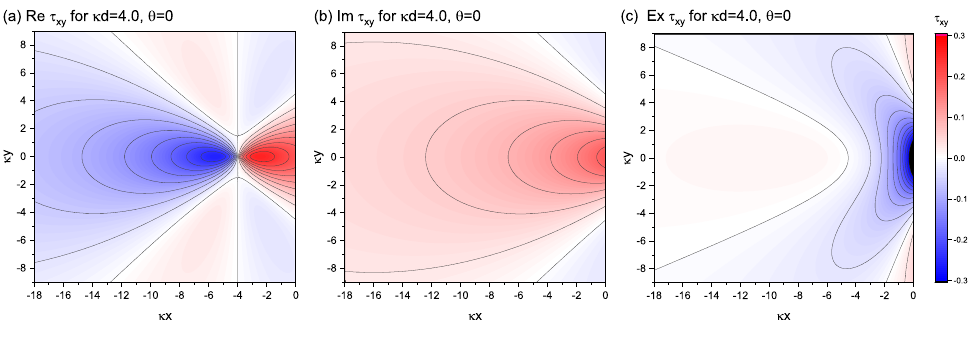
( re ) ( im ) ( ex ) xy , ( b ) τ xy , and ( c ) τ xy